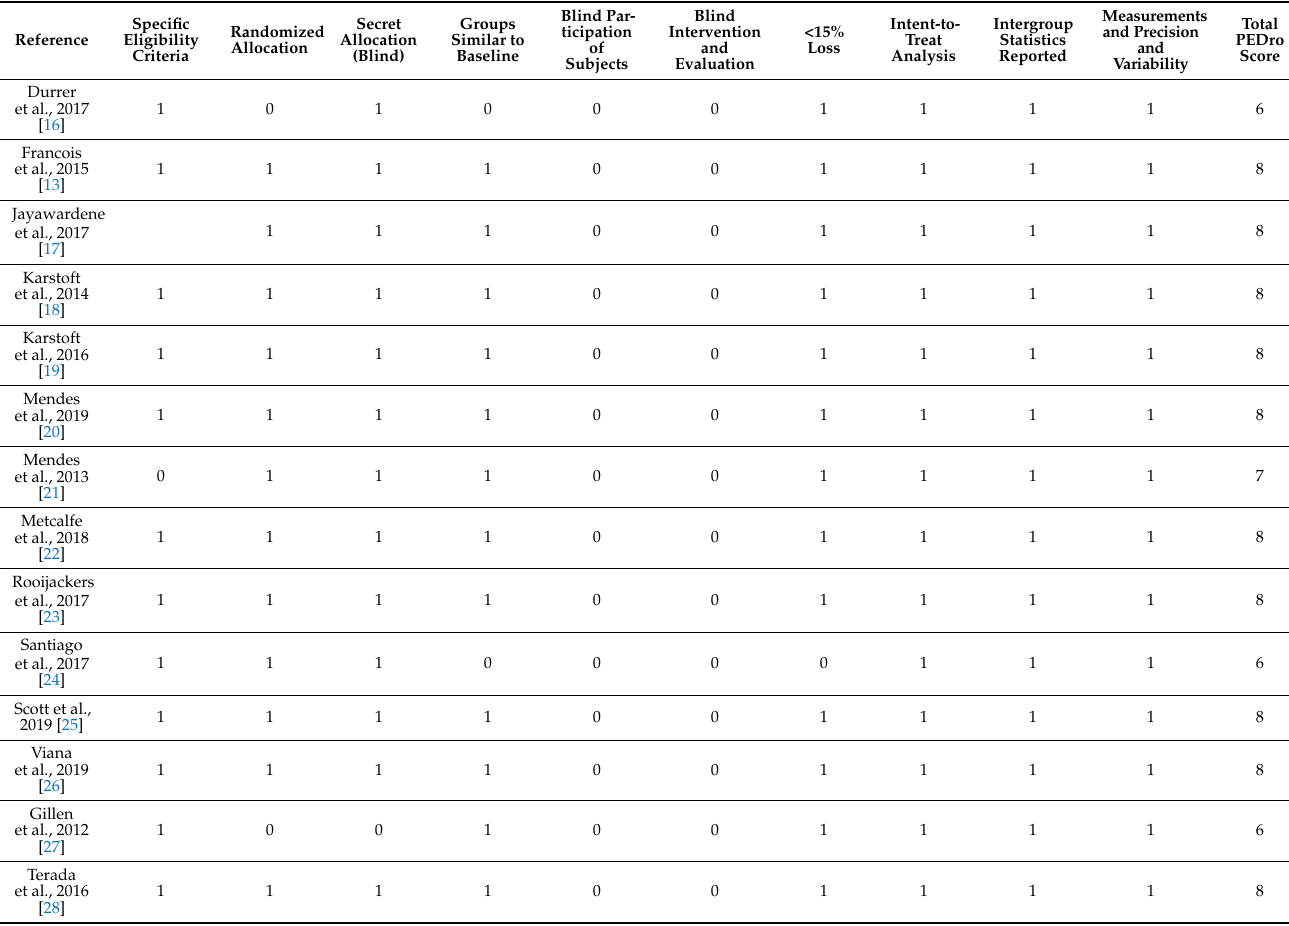
Table 1. PEDro score for the included